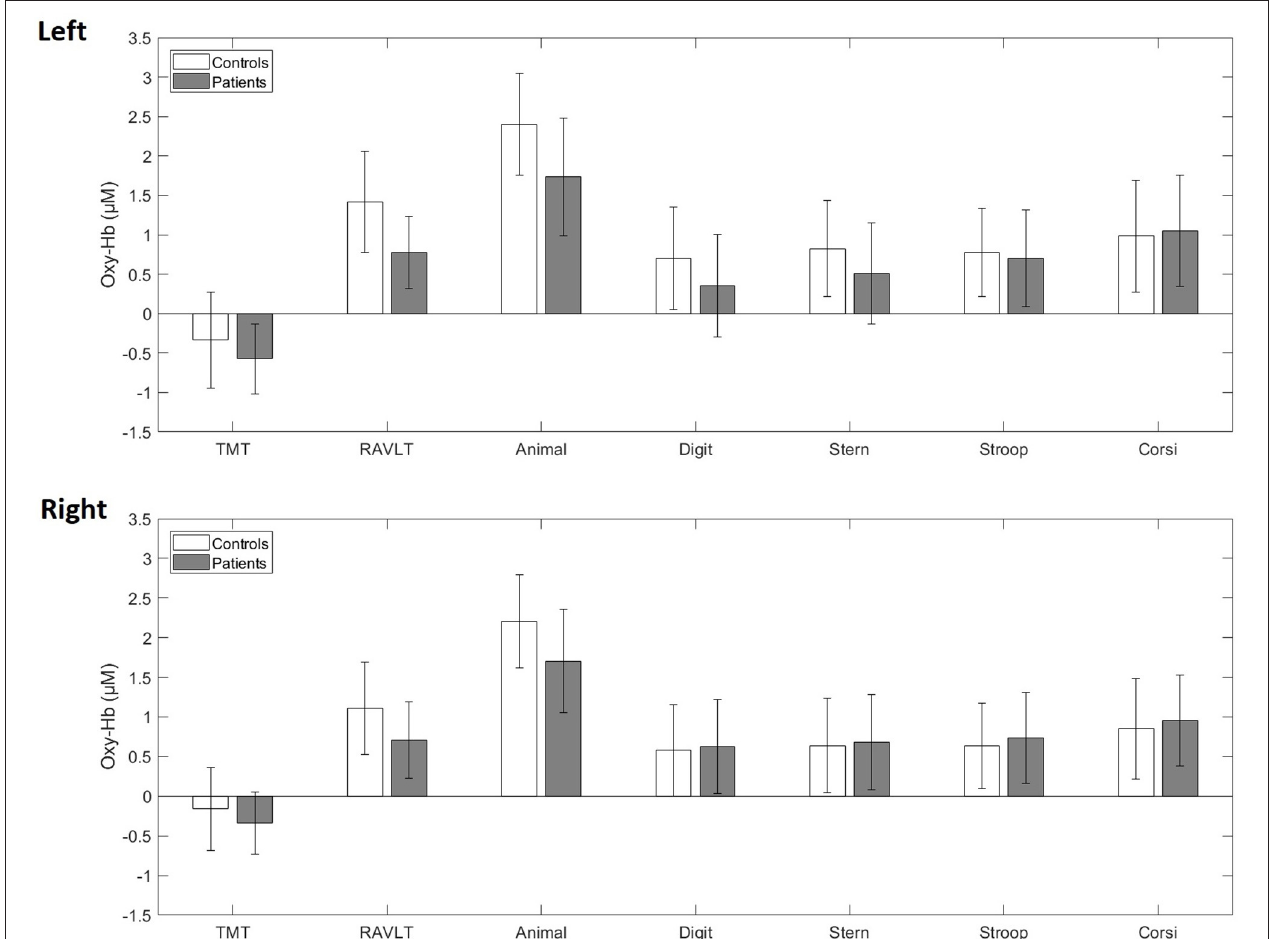
FIGURE 1 | Averaged blood oxygenation (oxy-Hb) and confidence intervals in patients (gray) and controls (white) during the cognitive test battery at baseline in the left and right fNIRS channel. TMT, Trail-Making-Test; RAVLT, Rey Auditory Verbal Learning Test; Animal, Animal Naming Test; Digit, Digit Symbol Coding Test; Stern, Sternberg Memory Test; Stroop, Emotional Stroop Test; Corsi, Corsi Block Tapping